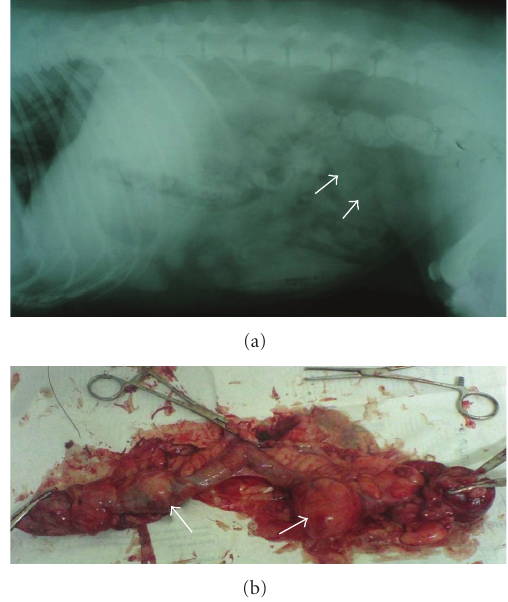
Figure 1: (a) Lateral abdominal radiograph of the bitch showing evidence of mild segmental enlargement of the uterus (arrows). (b) The excised uterus with distinct masses (arrows) in both